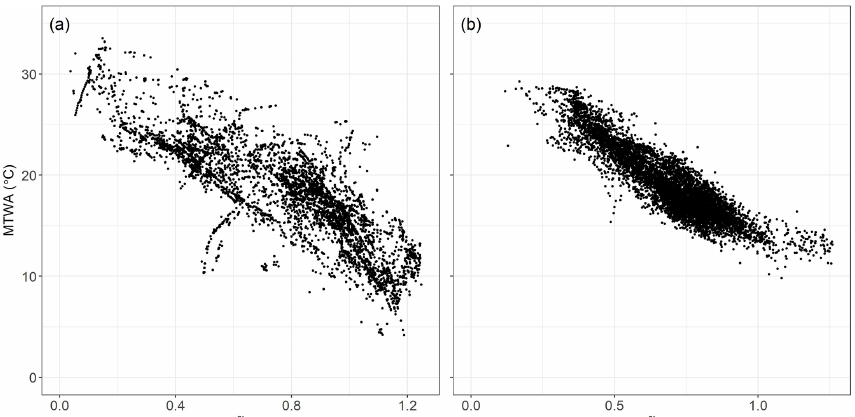
Figure 6. The relationship between mean temperature of the warmest month (MTWA) and plant-available moisture as represented by α (a) in the modern climate data set and (b) in the Holocene reconstructions.